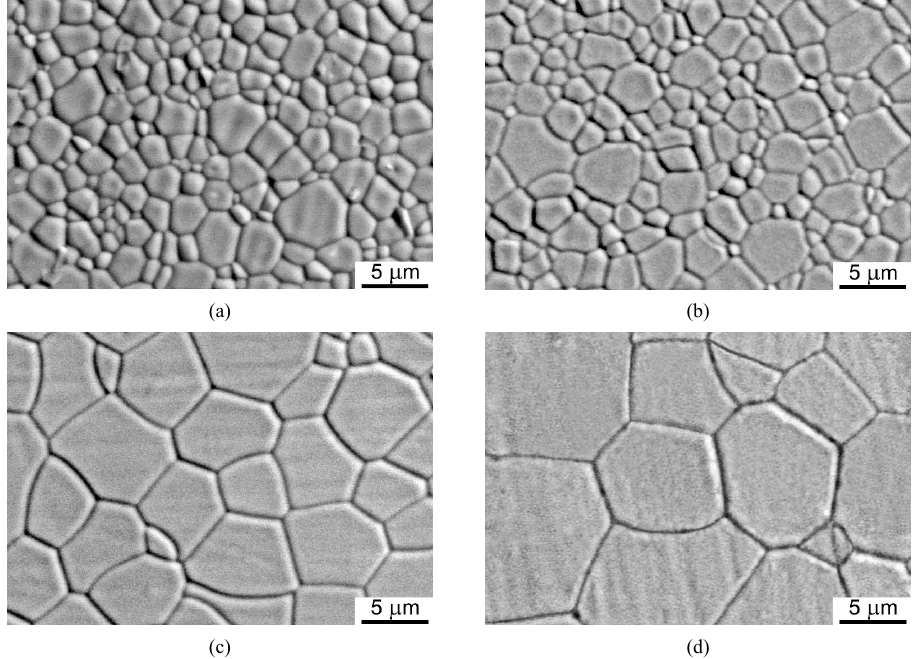
Fig. 9 SEM images of (Y 0.93 Yb 0.05 La 0.005 Zr 0.015 ) 2 O 3 ceramics obtained by vacuum sintering at T = 1750 ℃ (a), 1775 ℃ (b), 1800 ℃ (c), and 1825 ℃ (d) for 10